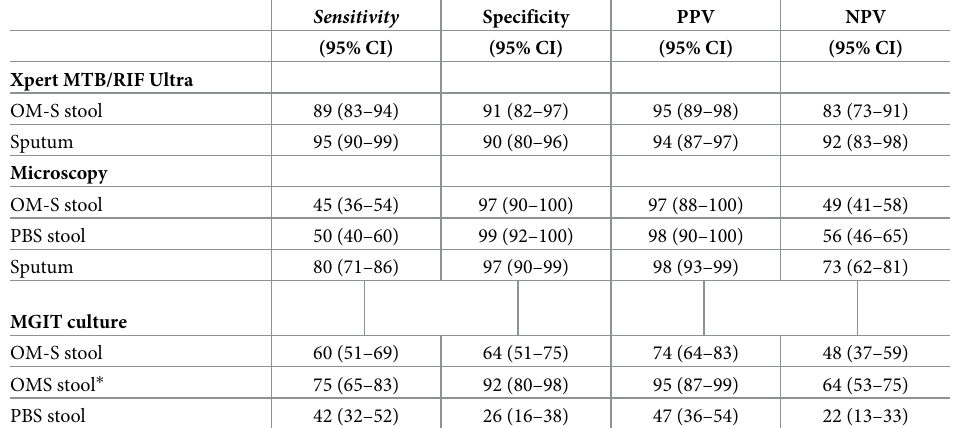
Table 3. Performance of Xpert MTB/RIF Ultra, smear microscopy and MGIT and culture [Reference: MGIT-